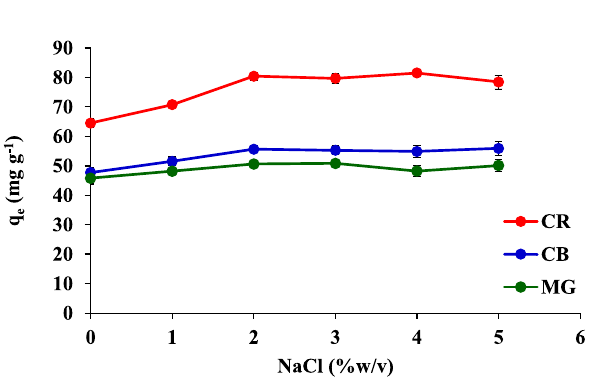
Figure 7. Effect of the ionic strength on the adsorption of CR, CB, and MG.